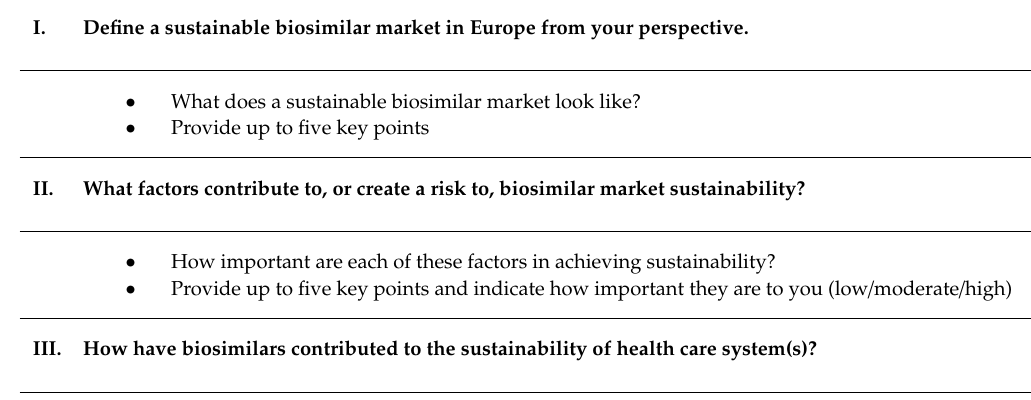
Table A1. Brainstorming questionnaire (Delphi process stage 1).